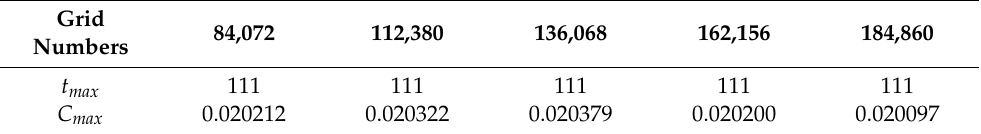
Table 5. Analysis result of RTD curves for different grid numbers.